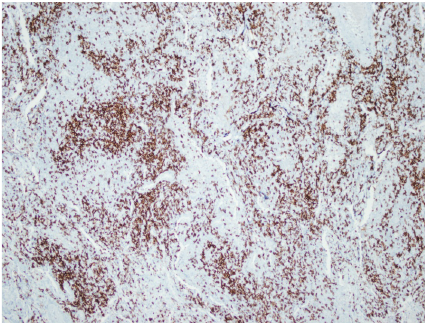
Figure 4: The cells were negative for CD5.